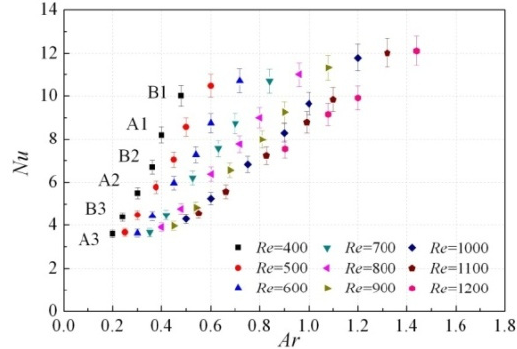
Figure 9. Nusselt number variation with A r , Va = 200.